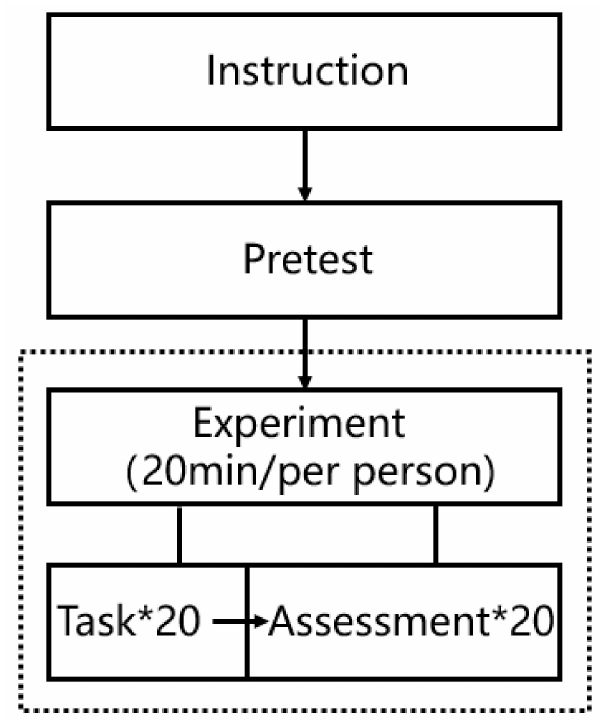
Figure 3. Intervention